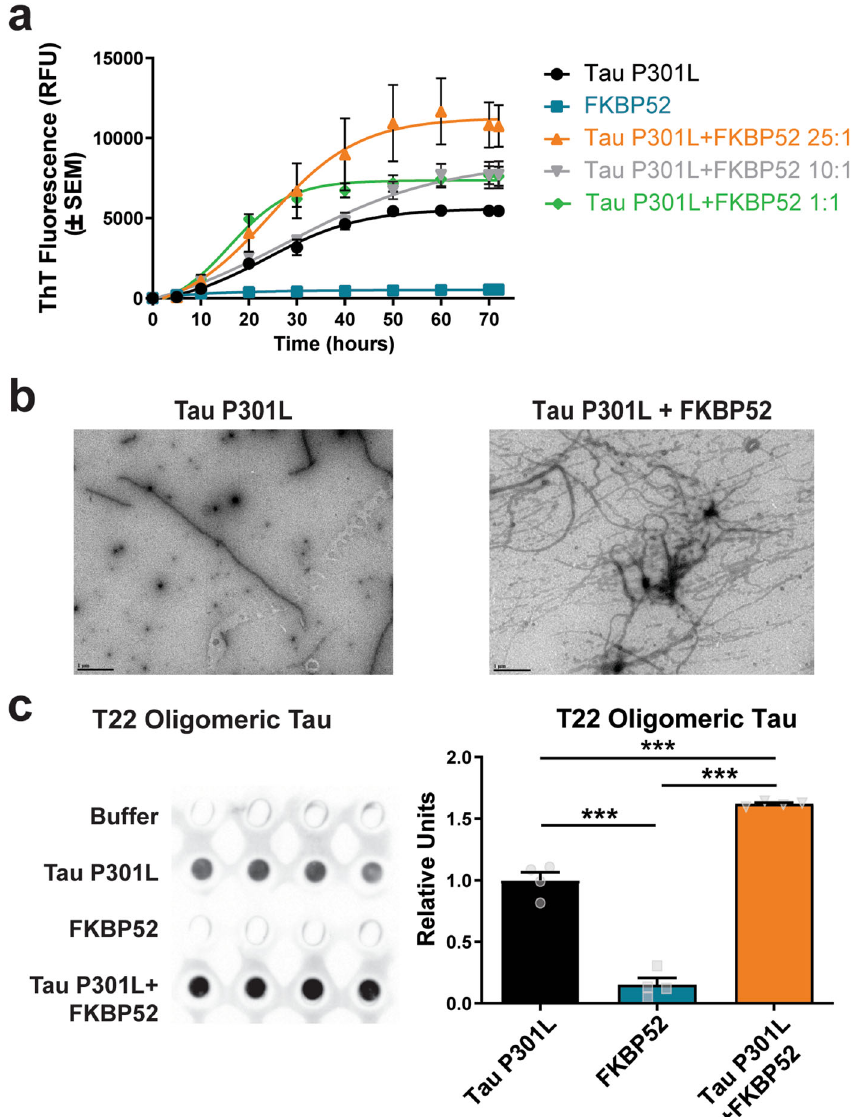
Fig. 1 FKBP52 accelerates tau P301L protein aggregation. a Using a thio fl avin T (ThT) fl uorescence assay, tau P301L (20 μ M) was monitored over 72 h with or without coincubation of FKBP52 (20, 2, or 0.8 µM). b Representative transmission electron microscopy (TEM) images are shown (×20,000 magni fi cation; scale bar 1 μ m). c Left panel: Representative dot blot analysis of tau aggregates incubated with 0.5 µg of tau P301L, 0.5 µg of FKBP52, or combination of (0.5 µg Tau and 0.5 µg FKBP52) probed with T22 antibody. Right panel: Quanti fi cation of T22 expression in dot blot with samples carried out in quadruplet. Results represented as standard error of the mean (±SEM); experiment was run in triplicate, ** p < 0.001 by one-way